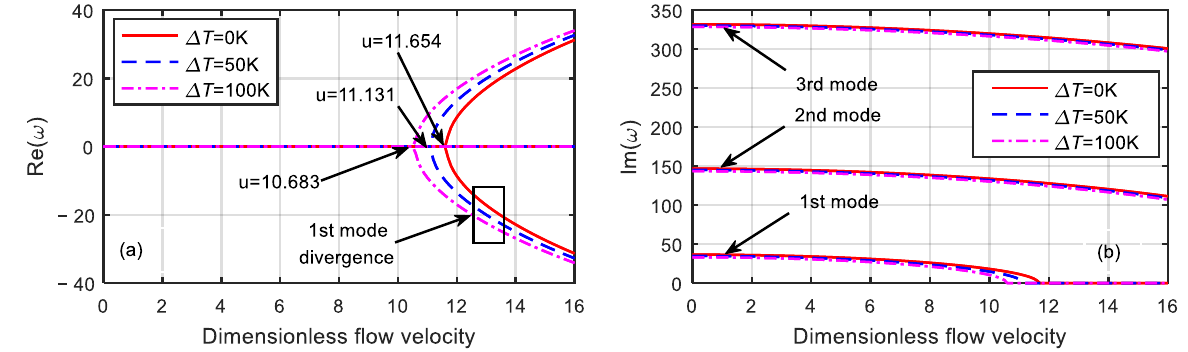
Figure 3. Dimensionless eigenfrequency variations with dimensionless flow velocity for various temperature differences ( δ = 1). ( a ) Real part. ( b ) Imaginary part.